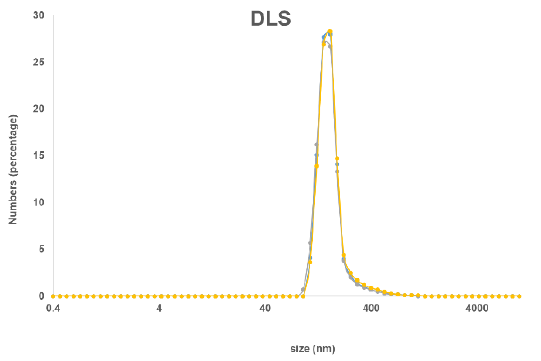
Figure 2. Dynamic light scattering (DLS) spectrum of MSNP-Pc1 in ethanol.